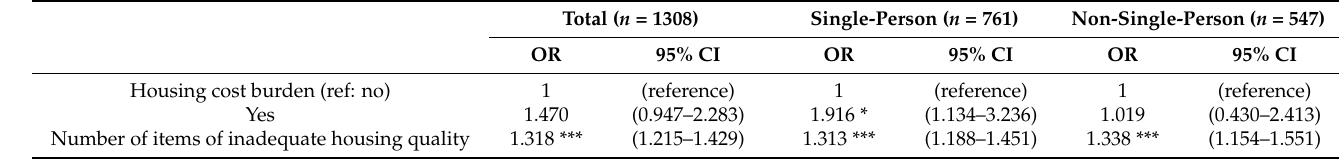
Table 2. Association between housing problems and depressive symptoms.